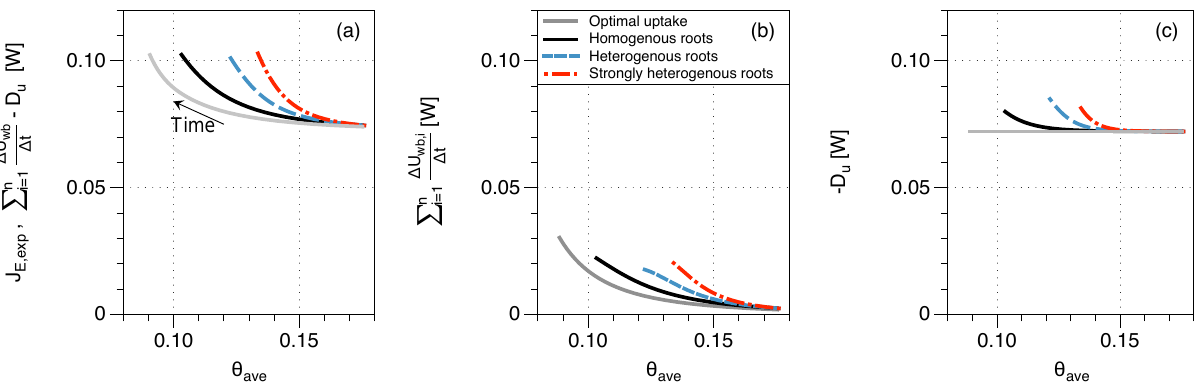
Figure 4. Components of the energy balance (Eq. 11) for the soil–plant system over the course of a drying experiment and different root water uptake scenarios. As in Fig. 3, the time axis was replaced by the average soil water content. (a) Total energy exported from the system at the root collar. It is the sum of the two components given in the other subplots. (b) Component due to decrease of soil binding energy, which is due to both soil drying and enhanced heterogeneity (compare Fig. 3). (c) Component due to energy dissipation by water flow from the soil into the